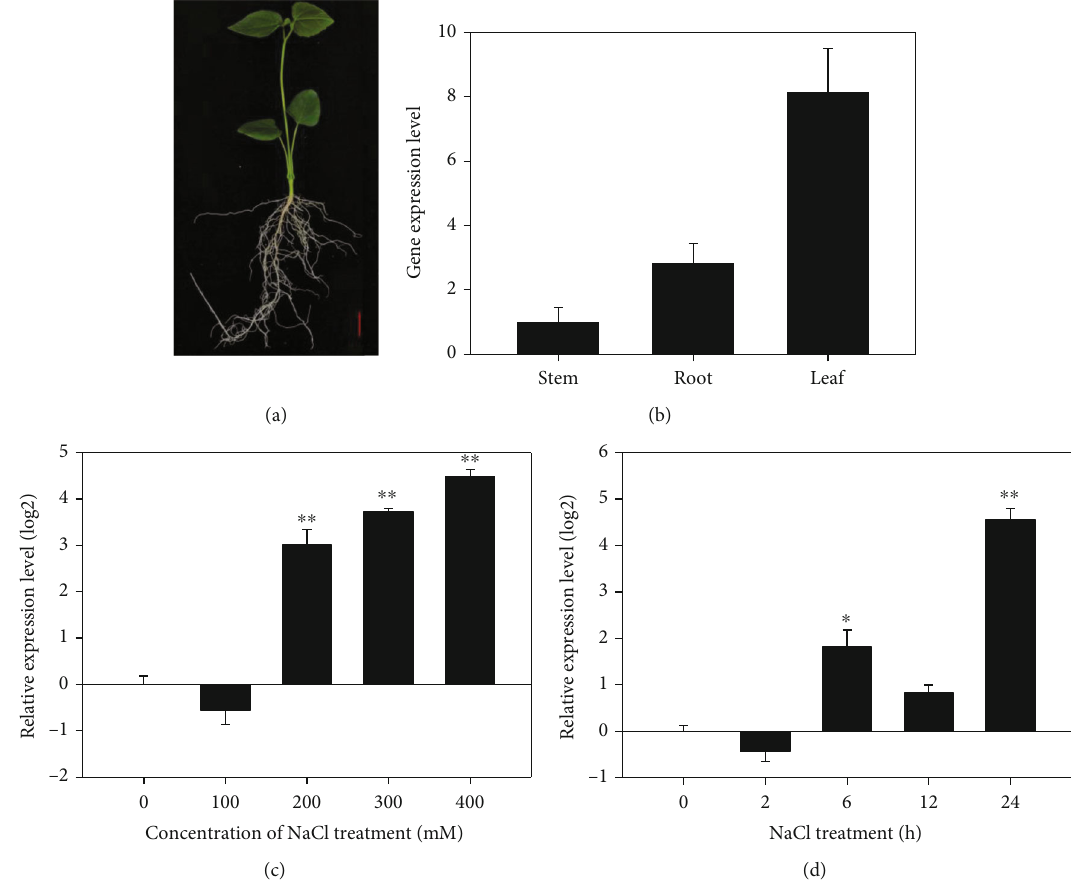
Figure 2: KvHSP26 expression analyses: (a) a representative of four-week-old K. virginica plants used in this research; (b) relative expression of KvHSP26 in the roots, stems, and leaves of four-week-old K. virginica plants; (c) relative expression of KvHSP26 in response to di ff erent concentrations of NaCl treatments; (d) relative expression of KvHSP26 after being treated with 300mM NaCl for 0, 2, 6, 12, and 24 hours. The results were the means of three biological replicates. The error bars were the standard deviations of the three replicates. ∗ and ∗∗ stand for the signi fi cant di ff erences at p < 0 : 05 and p < 0 : 01 ,